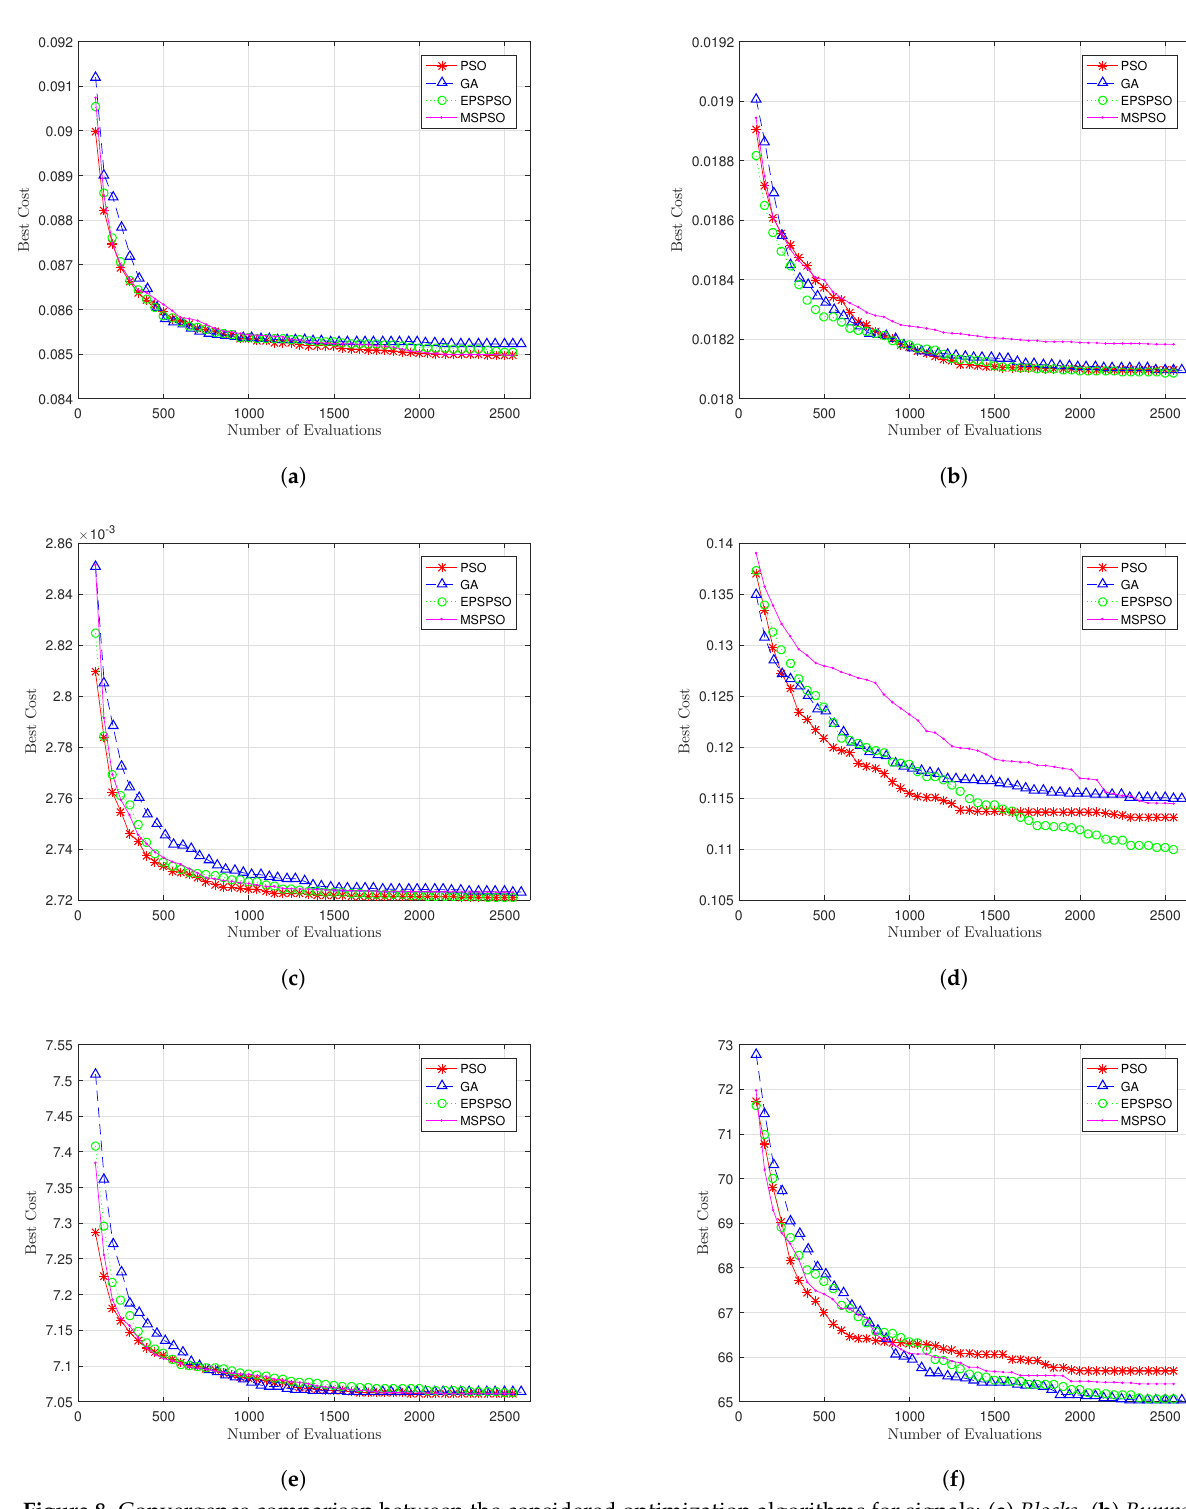
Figure 8. Convergence comparison between the considered optimization algorithms for signals: ( a ) Blocks . ( b ) Bumps . ( c ) Doppler . ( d ) HeaviSine . ( e ) Piece-Regular . ( f ) Sing